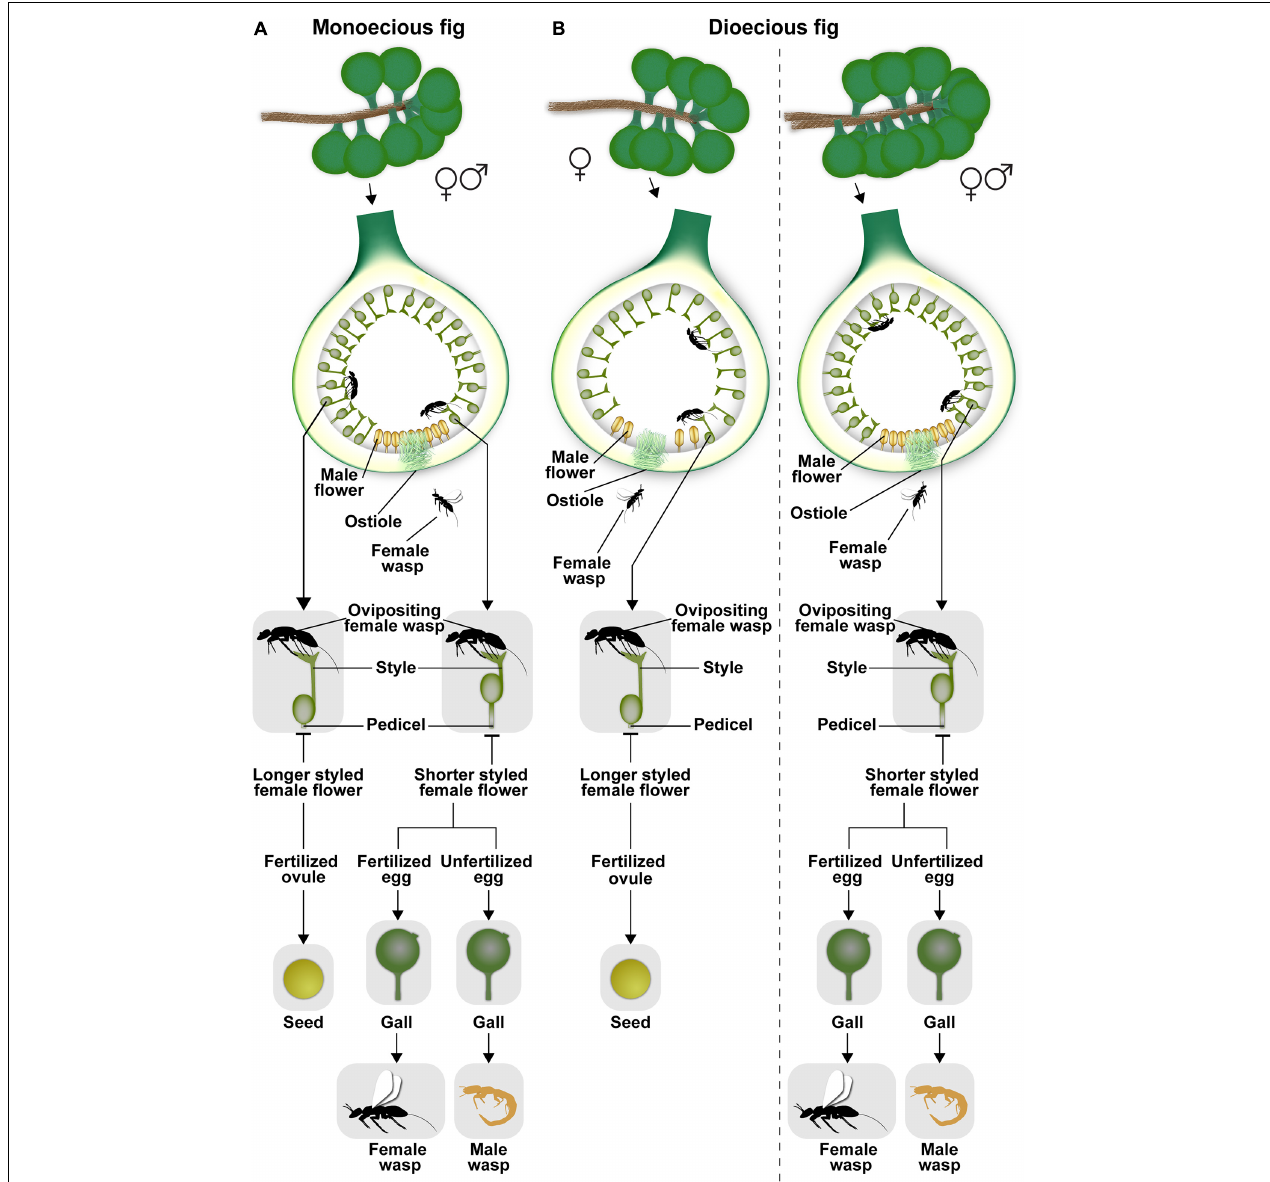
FIGURE 1 | (A,B) The life cycles of gall-inducing pollinating fig wasps in monoecious and dioecious figs. The extreme sexual dimorphism and the lack of reproductive success in female trees in dioecious fig species is clearly depicted. Illustration by Priya B.R.